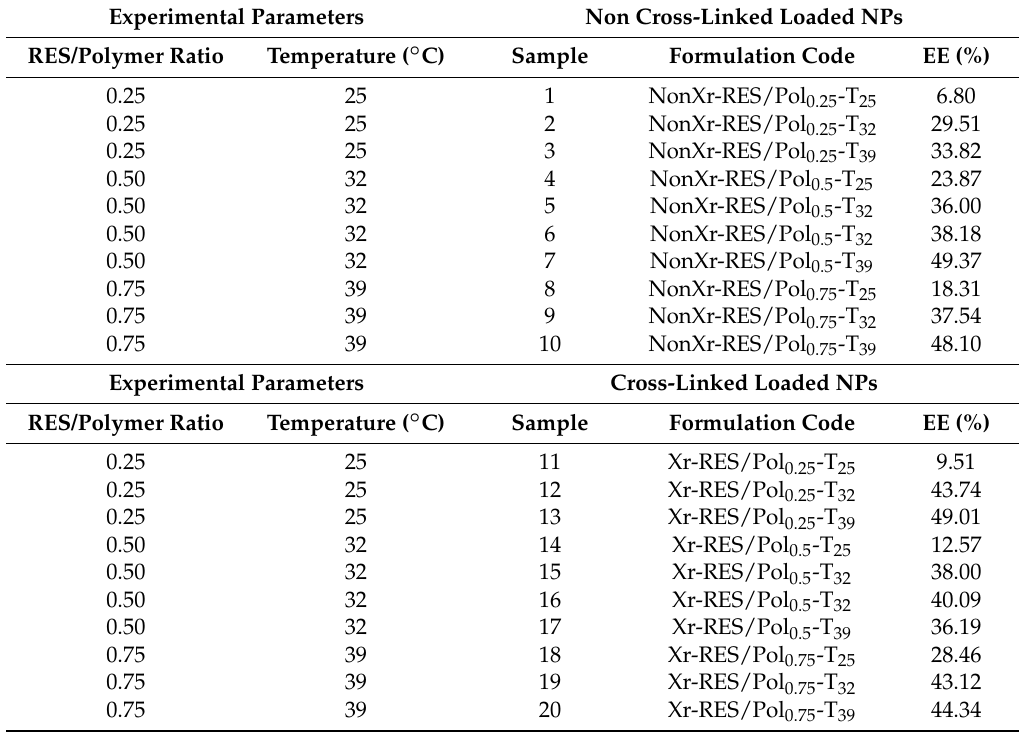
Table 1. Experimental encapsulation efficiency values of resveratrol loaded NPs (nanoparticles) for non-cross-linked and cross-linked systems at different RES (Resveratrol)/polymer ratios and temperatures following the experimental design 1